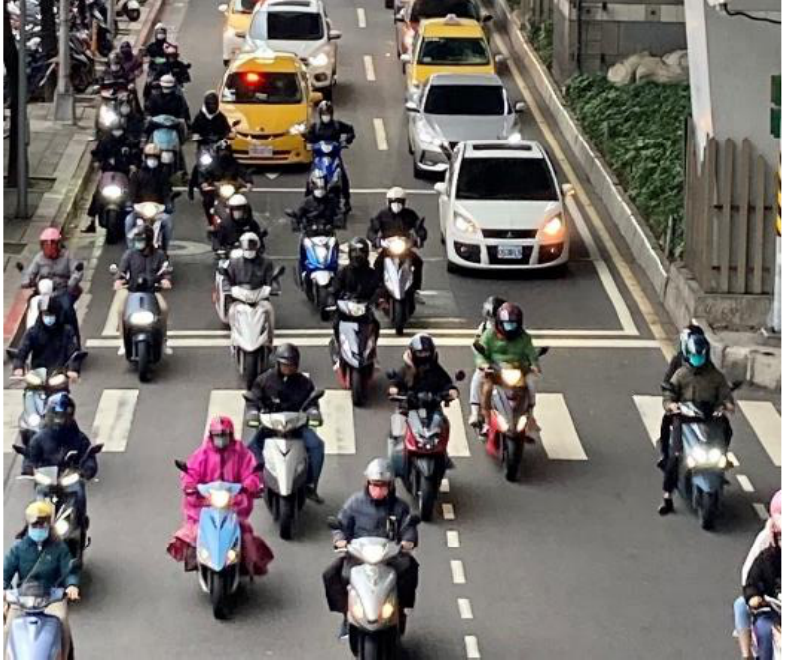
Figure 1. Scene at a traffic light in Taipei city in Taiwan.